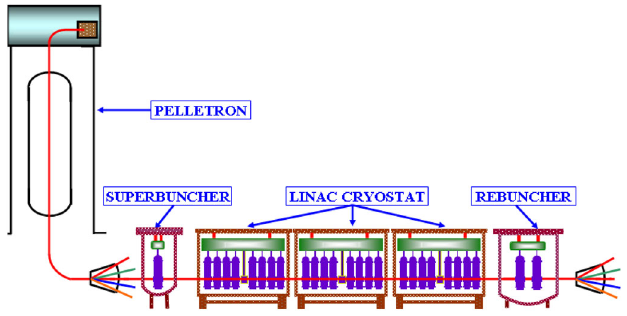
FIG. 1. (Color) The schematic of the Pelletron and the super- conducting linear accelerator of